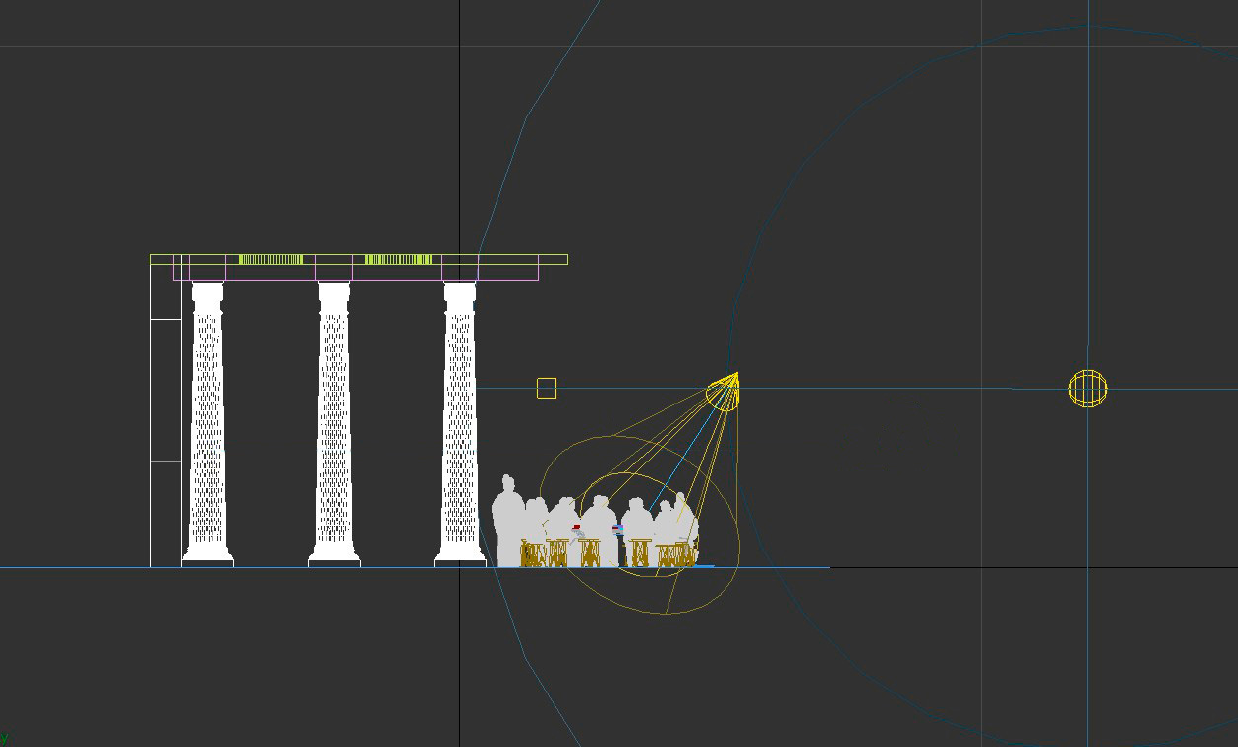
Figure 12. Side view with stage lights.